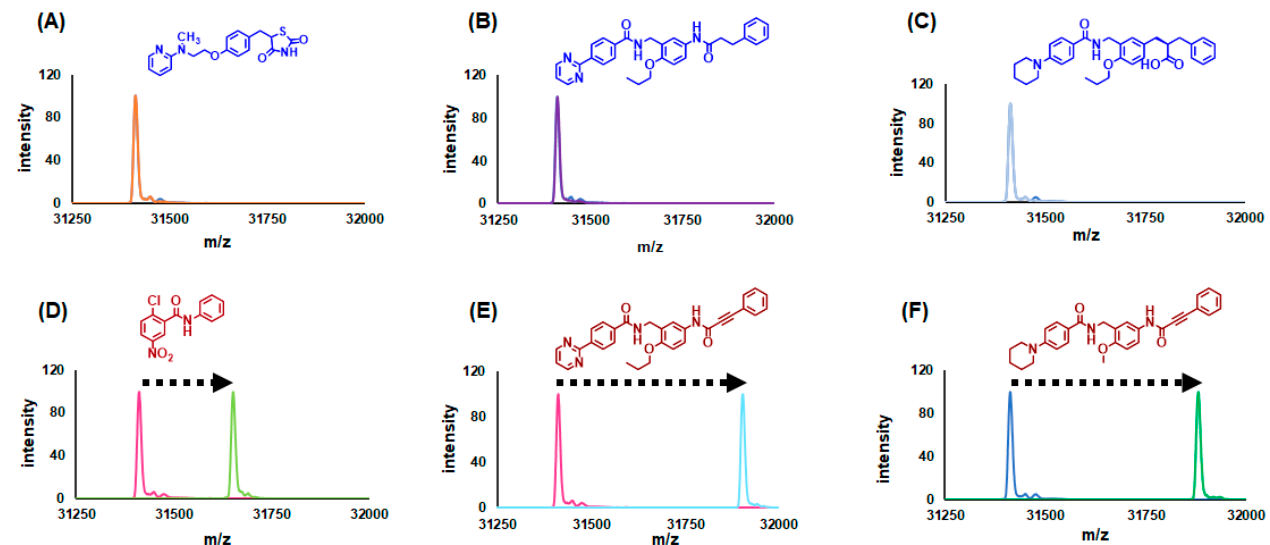
Figure 10. ( A – F ) ESI ‐ MS spectrograms after the 24 ‐ h incubation of apo hPPAR γ in the presence of various hPPAR γ ligands. ( A ) Rosiglitazone (agonist). ( B ) 13m . ( C ) MEKT ‐ 21. ( D ) GW ‐ 9662 (antagonist). ( E ) MMT ‐ 160. ( F ) MMT ‐ 160 derivative.